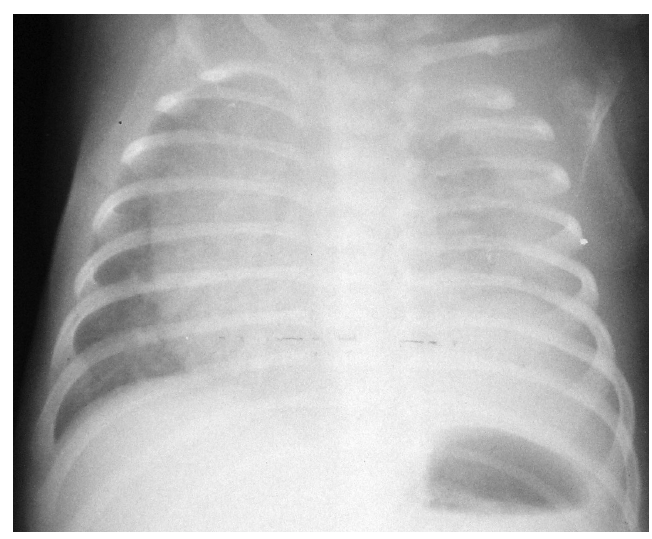
FIGURE 1. Chest X-ray showing a left pleural effusion.